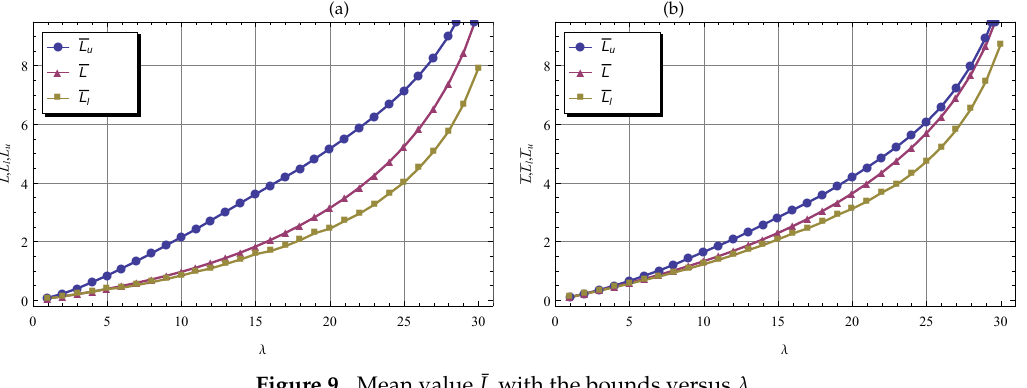
Figure 9. Mean value ¯ L with the bounds versus λ .